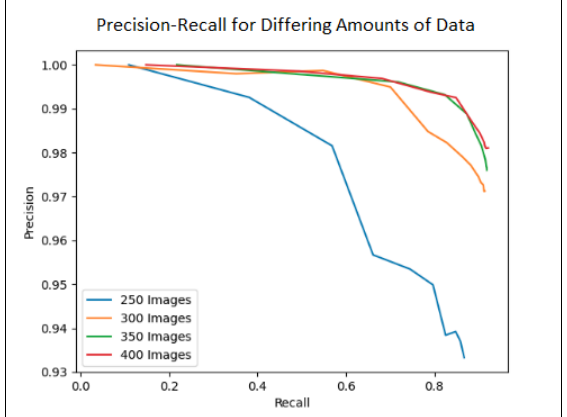
Figure 13. Precision–recall results—we trained multiple models on differing amounts of data (250 im- ages, 300 images, 350 images, and 400